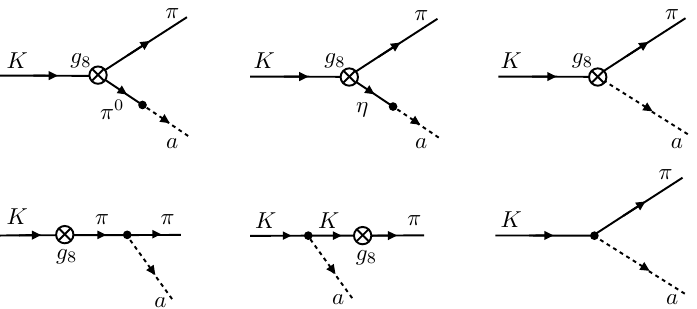
¯ K 0 → π 0 a decay amplitudes